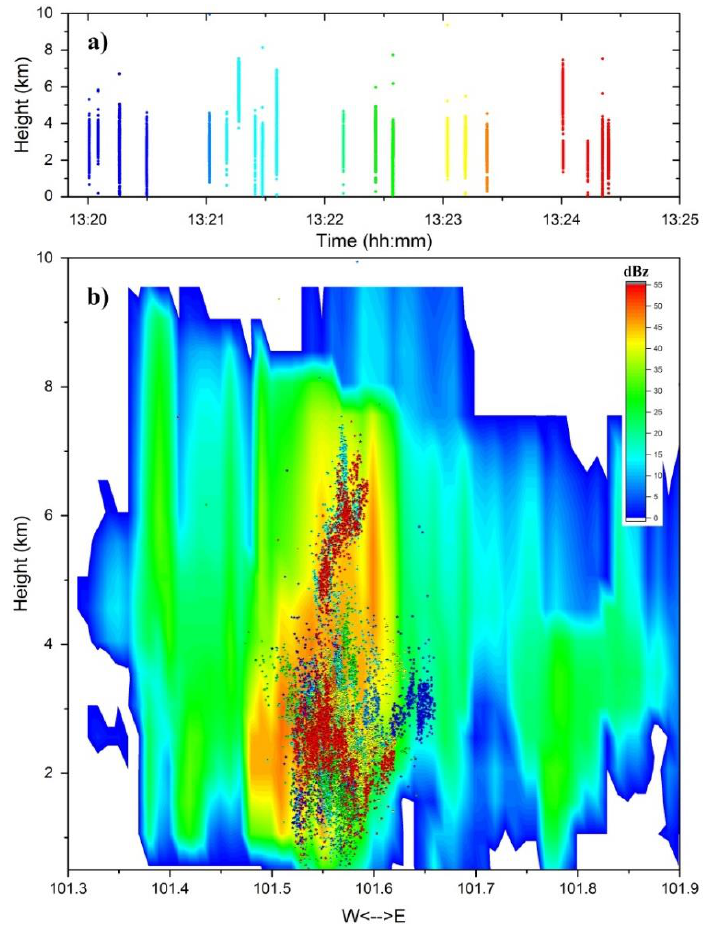
Figure 7. Superposition of the VHF radiation source positioning results and radar echoes (13:20–13:25). ( a ) Height-time plots; ( b ) North-Southward vertical projection superimposed by vertical section of radar.